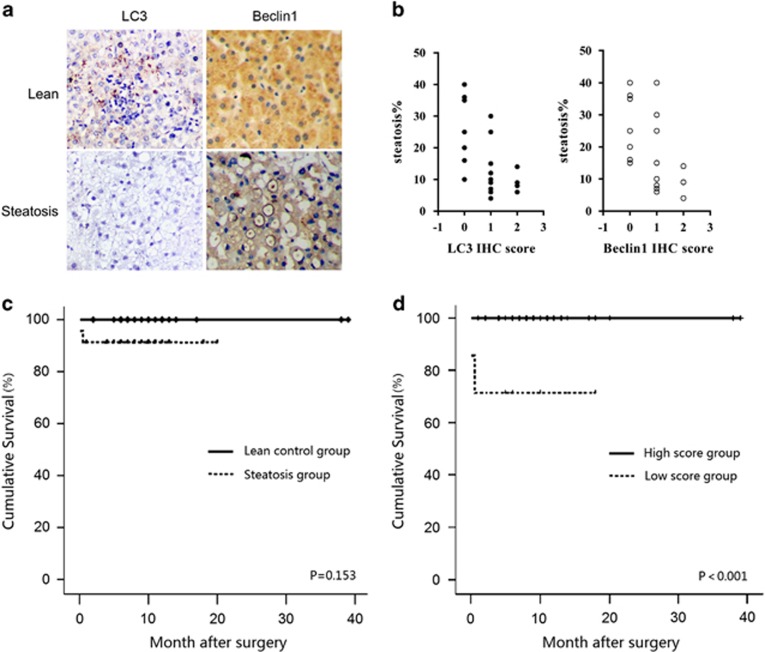
Low expression of LC3 and Beclin-1 in reperfused human steatotic liver allografts is associated with degree of steatosis and poor transplant outcome. (a) Human steatotic and control liver samples taken after 1 h of reperfusion during liver transplant surgery were analyzed by IHC. Autophagy markers LC3 and Beclin-1 displayed low expression in steatotic liver. (b) Pearson correlation test was used for analysis of correlations between LC3 (left) and Beclin-1 (right) expression score and percentage of steatosis. (c) Kaplan–Meier analysis of the data from 46 cases of liver transplantation recipients in survival rates between the steatotic liver allograft group (n=23) and the lean control liver allograft group (n=23). (d) Kaplan–Meier survival curves of overall survival in all transplant patients according to the summed LC3 and Beclin-1 expression score. Low expression score: sum of LC3 and Beclin-1 score ≤1. High expression score: sum of LC3 and Beclin-1 score >1